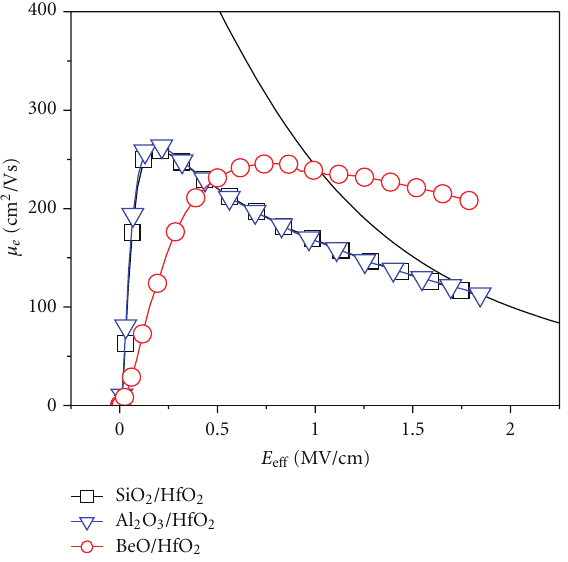
Figure 10: E ff ective channel mobility of NMOSFETs with three gate